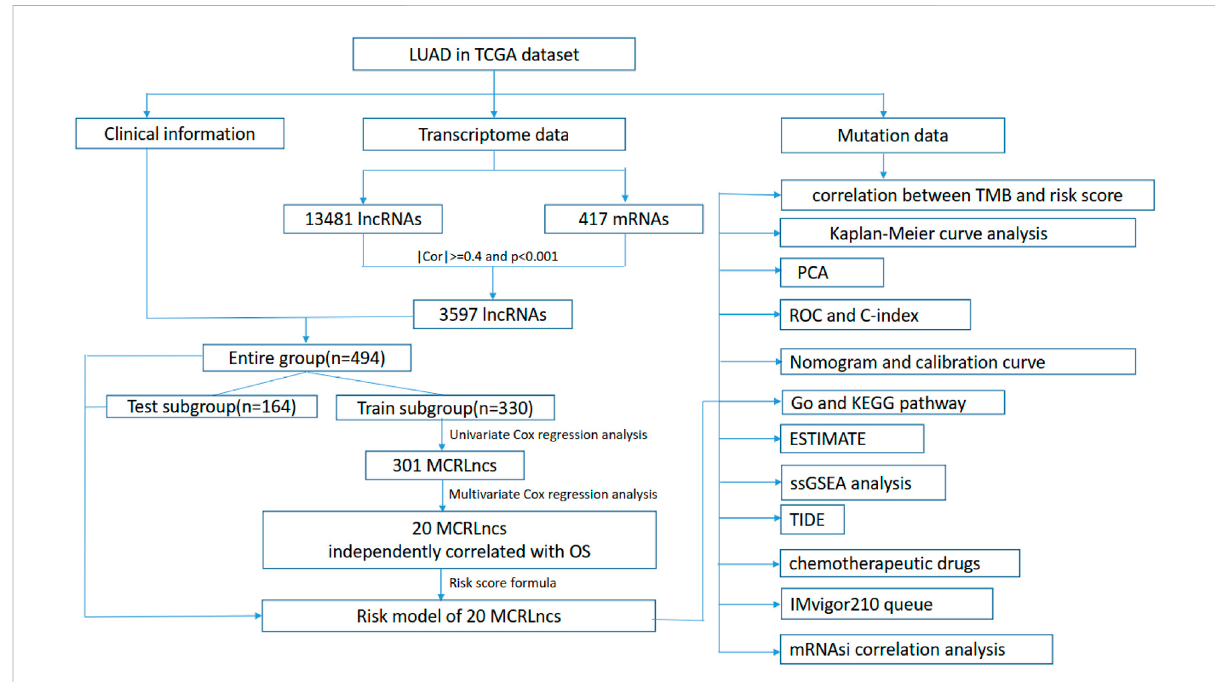
FIGURE 1 Flow chart of this